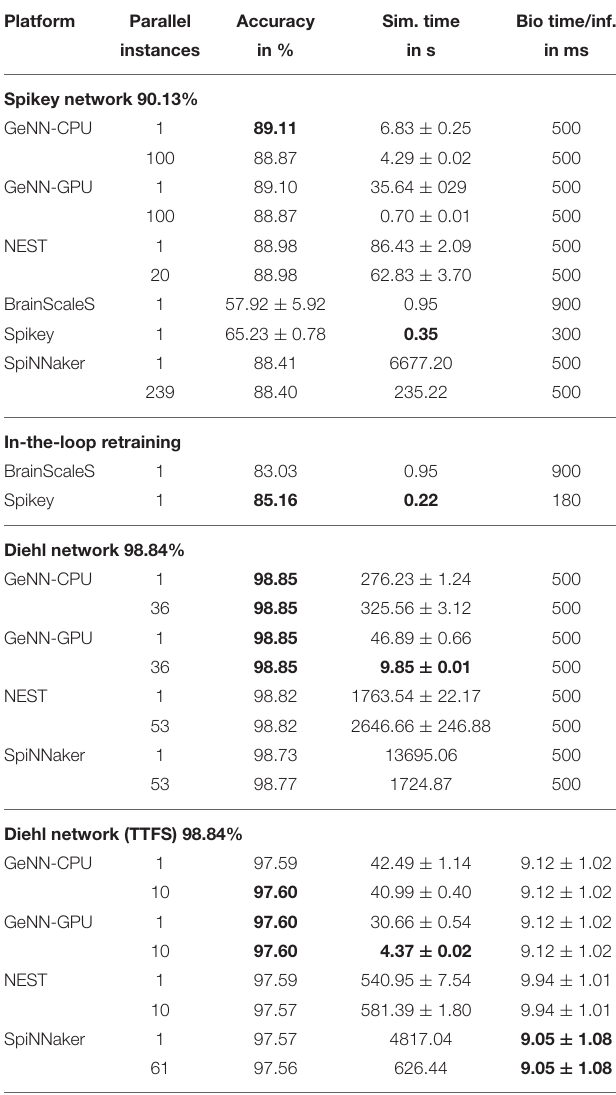
TABLE 3 | Results of pre-trained and converted DNNs. Platform Parallel Accuracy Sim. time Bio